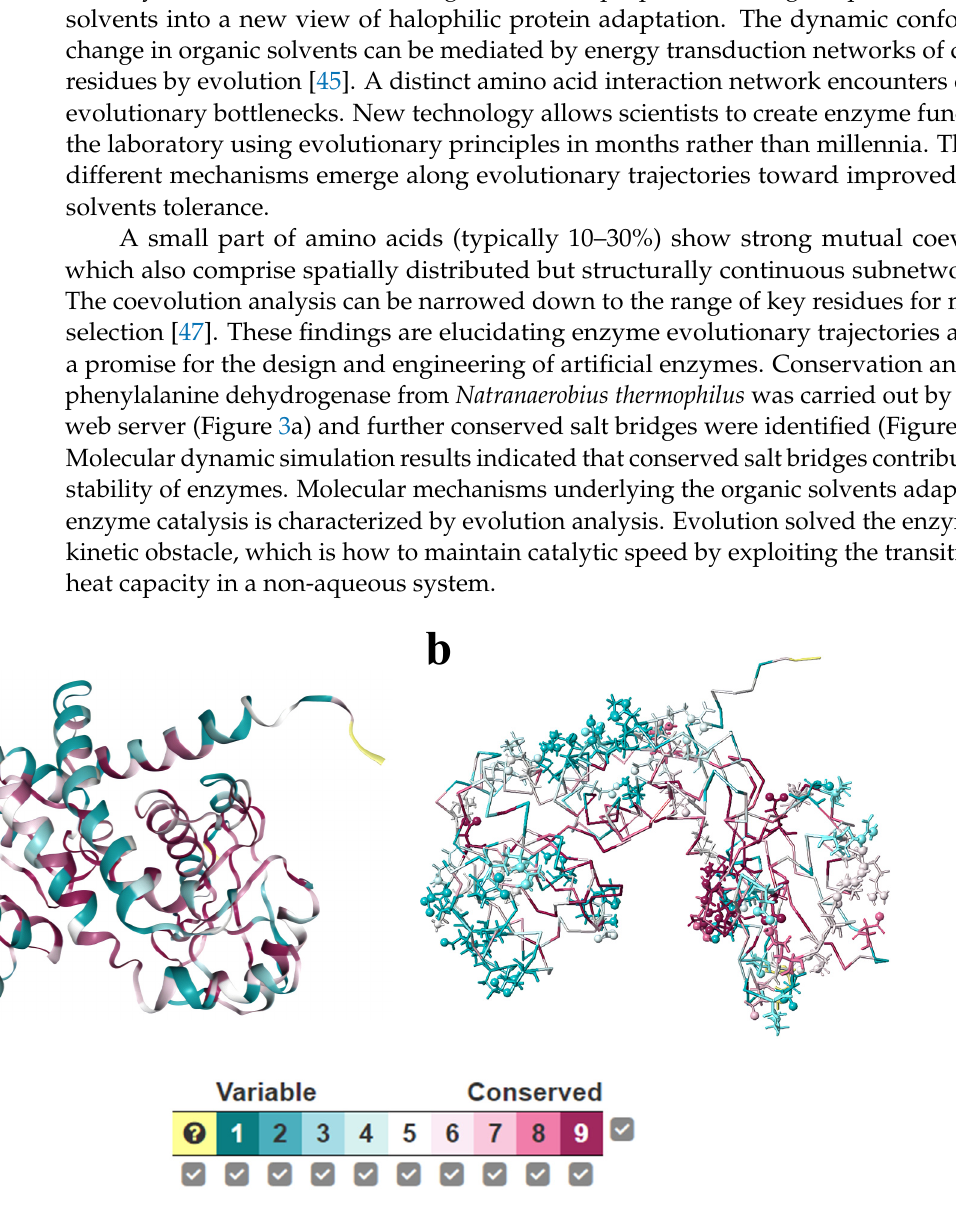
Figure 3. Conservation analysis of phenylalanine dehydrogenase from Natranaerobius thermophilus , ( a ) Conservation analysis of all amino acid residues; ( b ) conserved salt bridges. ( a ) Conservation analysis of all amino acid residues; ( b ) conserved salt